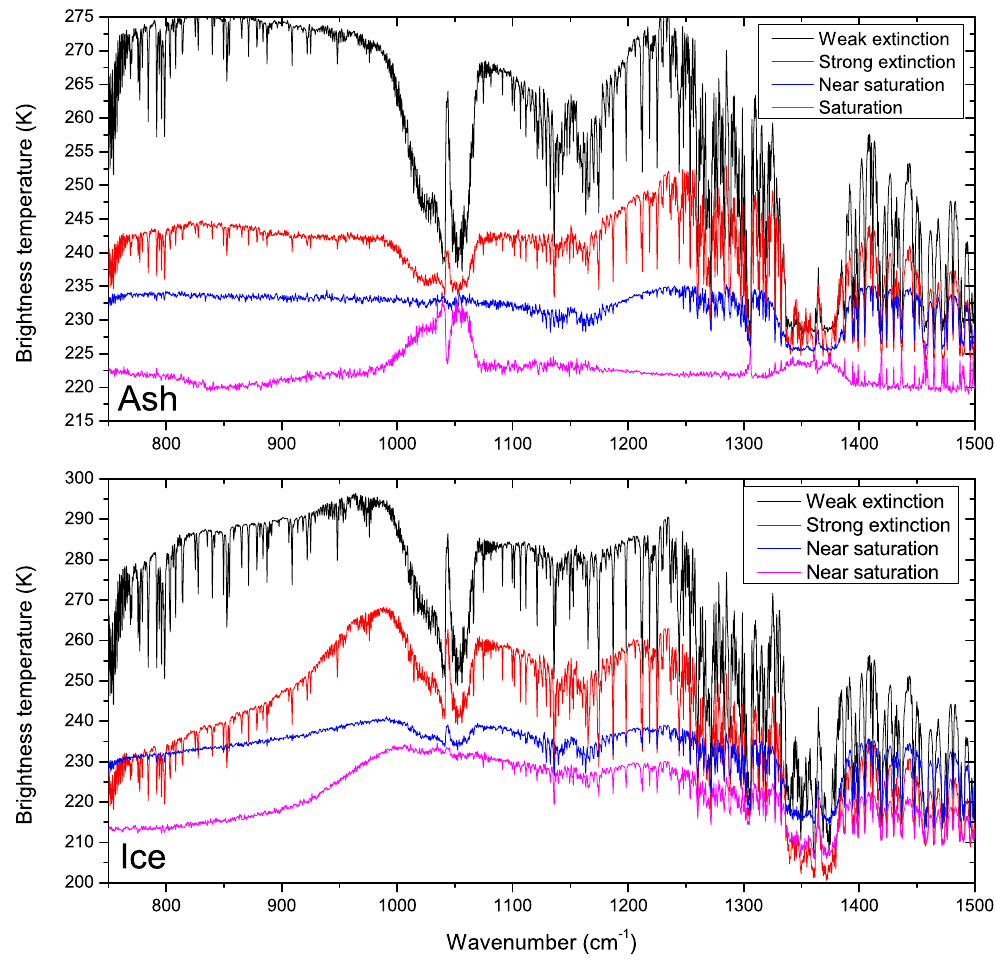
Fig. 8. Observed IASI spectra from the 2008 Kasatochi (top) and 2011 Nabro eruptions (bottom) illustrating the effect of volcanic aerosol (ash and ice). Different degrees of aerosol extinction demonstrate the damping of the SO 2 signature. Note that some of the differences are also due to the different total column of water